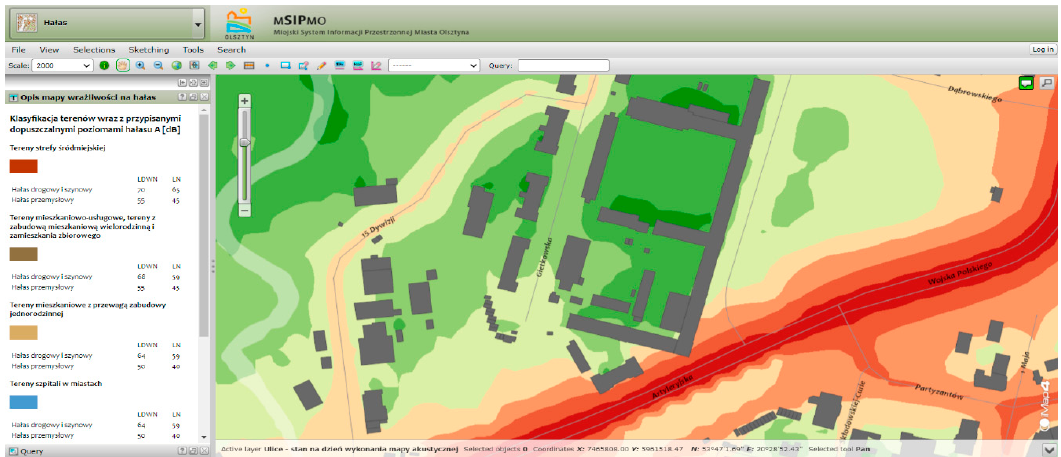
Figure 5. Noise Map of the City of Olsztyn developed in the City Spatial Information System of the City of Olsztyn (MSIPMO). Source: own study based on data from https://msipmo.olsztyn.eu/imap/.